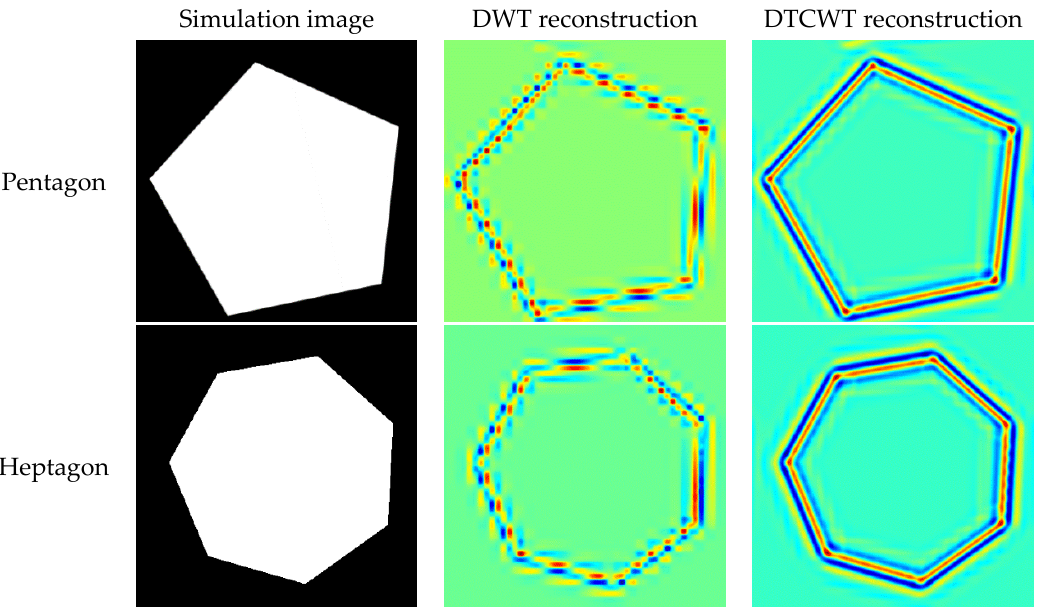
Figure 5. The reconstruction comparison between DWT and DTCWT.